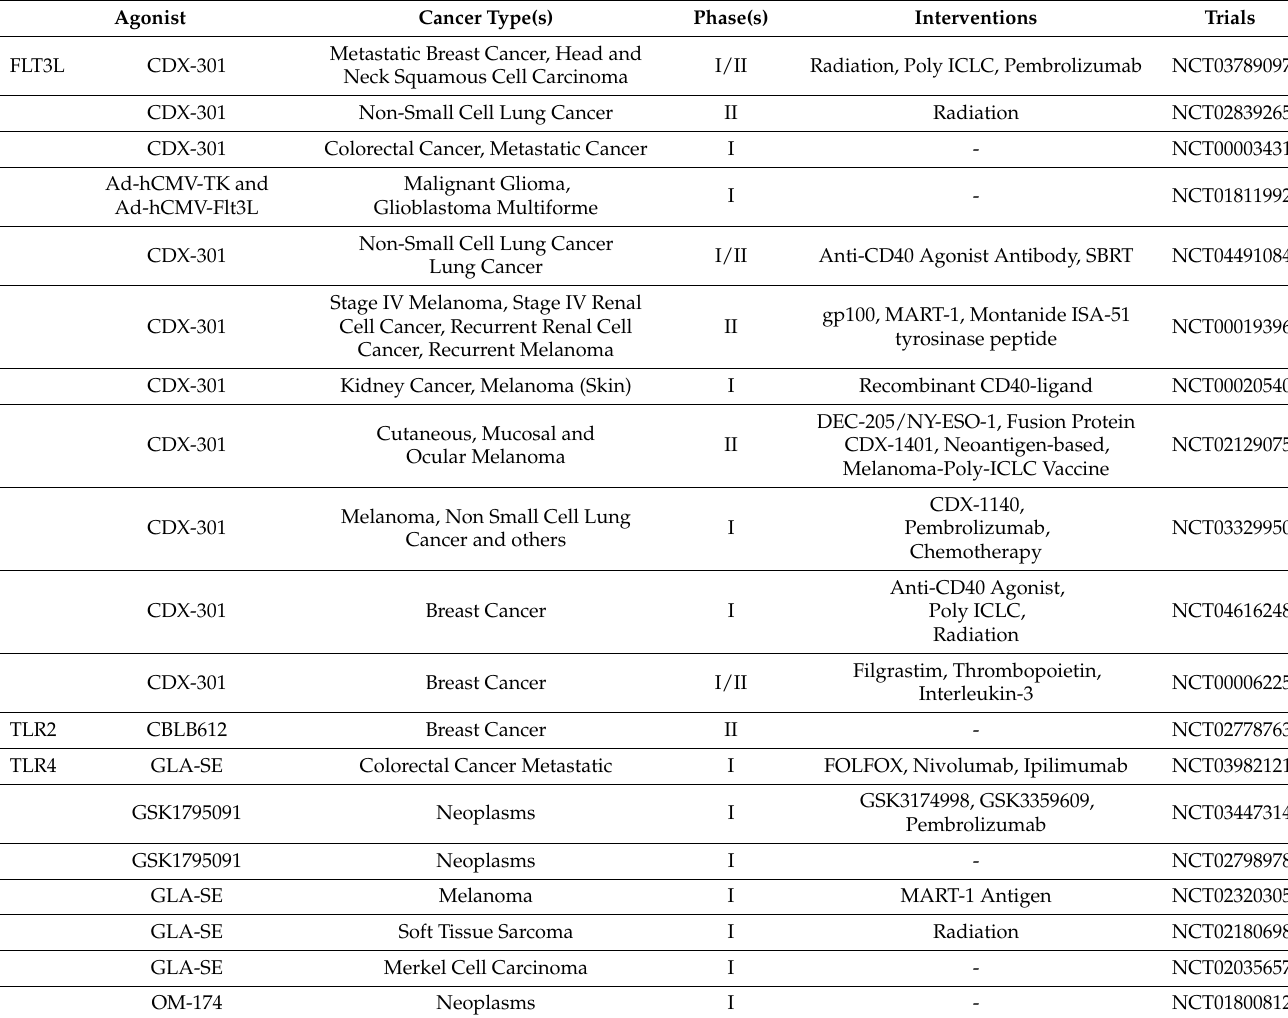
Table 2. Agents used in the clinic to stimulate immunogenic functions of DCs in cancer as monotherapy or in combination. Agonist Cancer Type(s) Phase(s) Interventions